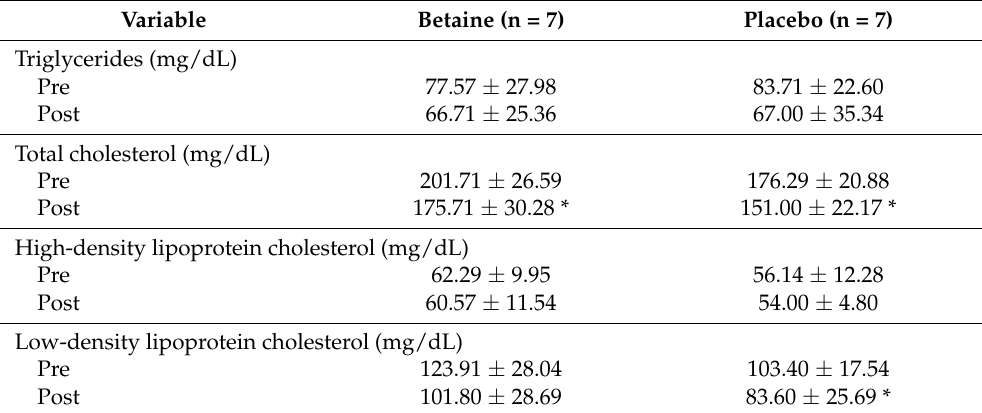
Table 2. Changes in the blood lipid profile before and after 6 weeks of betaine supplementation. Variable Betaine (n = 7) Placebo (n =